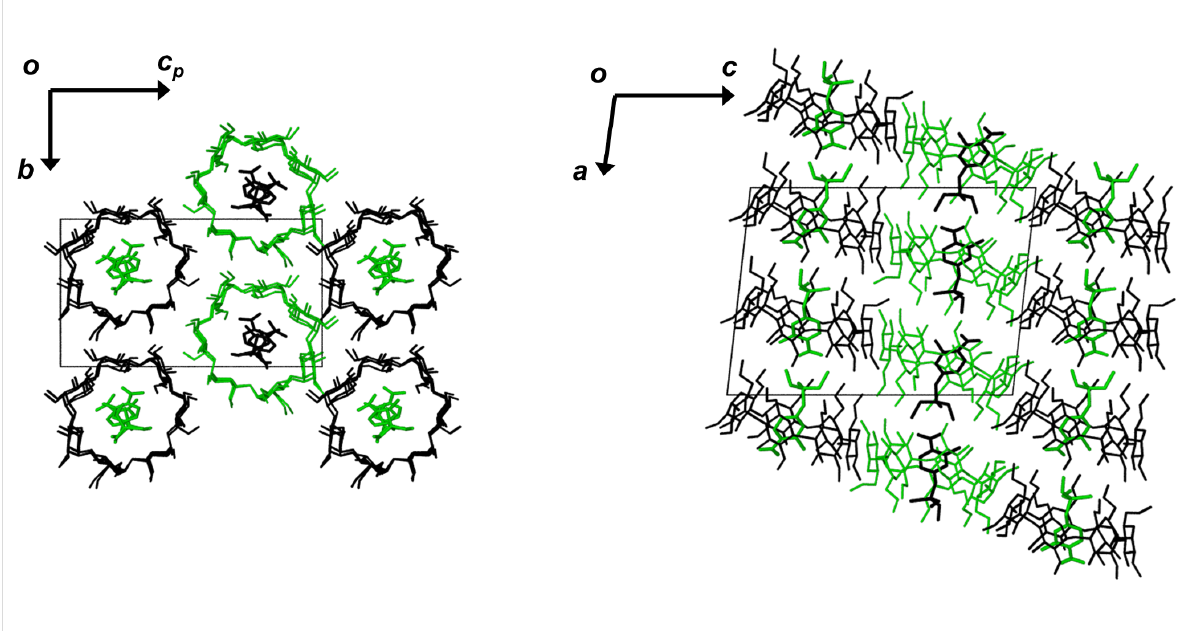
Figure 8: Packing diagrams of the DIMEB· 1 structure, viewed along [100] (left) and [010] (right). The symmetry related molecules are distinguished by the reverse green and black host and guest molecules. For clarity, only guest molecules A and B are shown and the hydrogen atoms have been